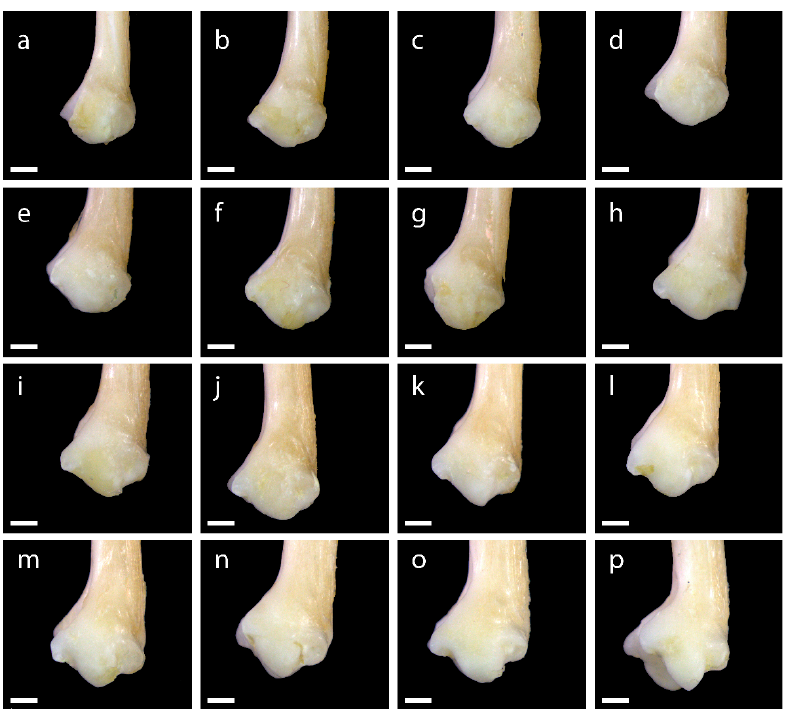
Figure A16. Microscopic images of the lateral right view of the pinnules of P. bichir PO1. The images ( a – p ) correspond to the 1st, 2nd, 3rd, 4th, 5th, 6th, 7th, 8th, 9th, 10th, 11th, 12th, 13th, 14th, 15th, and 16th pinnules, respectively. Scale = 1 mm.